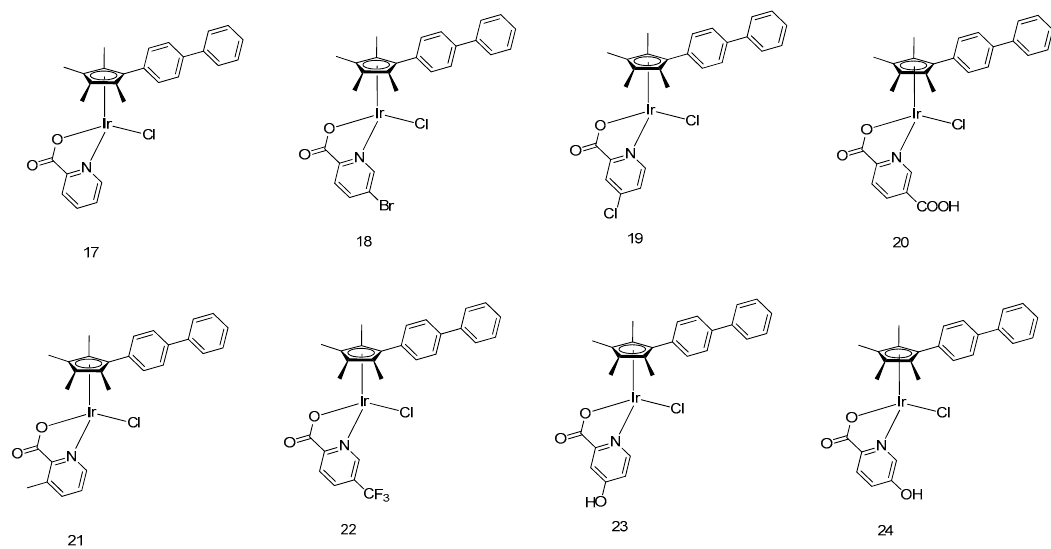
Figure 7. Organometallic half-sandwich iridium(III) with α -picolinic acid O^N-chelating ligands.